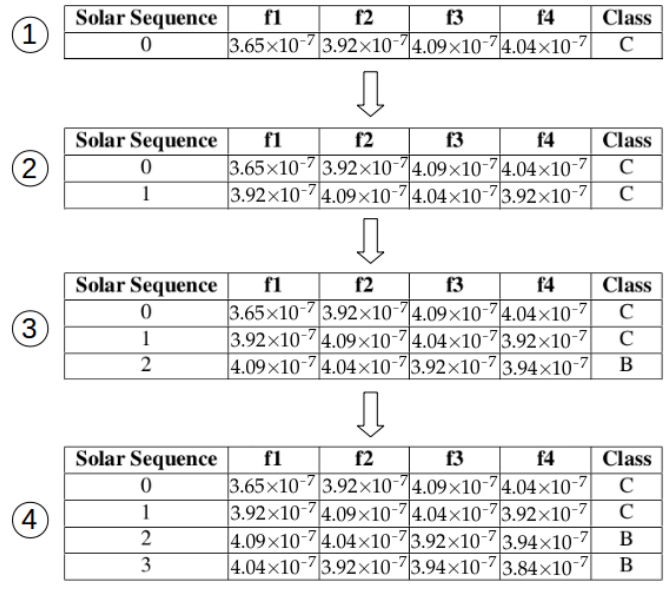
Figure 2. Illustration of the sequential execution approach used in SS.